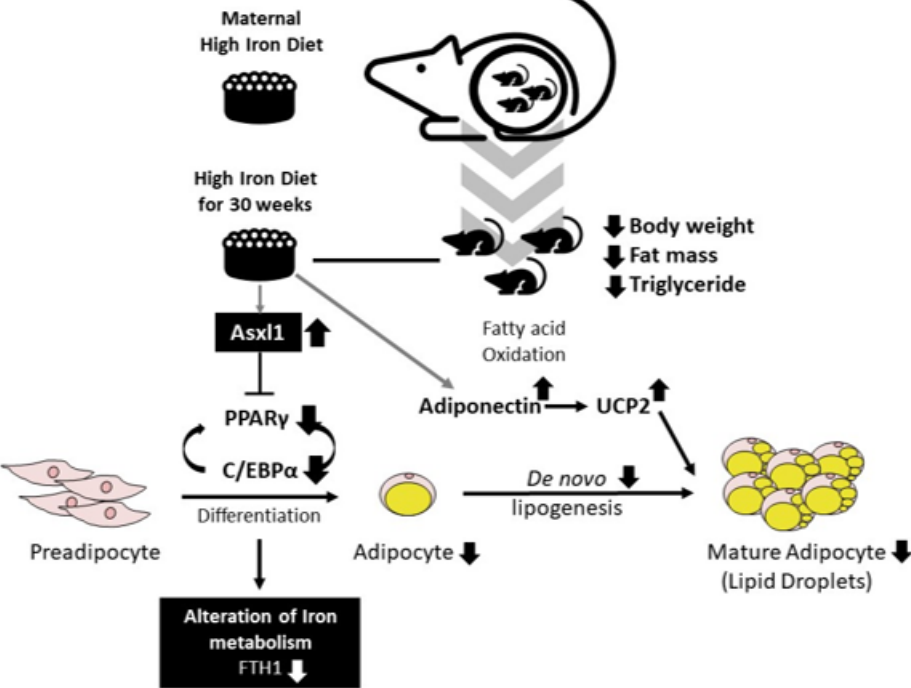
Figure 7. Summarized scheme of the Heft diet affecting iron and lipid metabolism in mice in the present study.